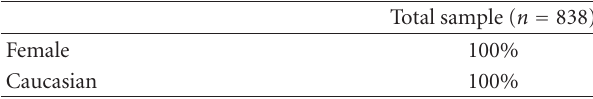
Table 3: State-Trait Anger Expression Inventory (STAXI).